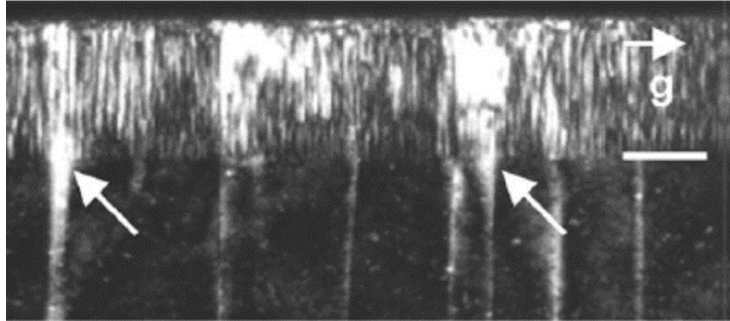
Figure 8. Cross-sectional TEM images of InAlN layer showing phase separation [58]. Figure reproduced with permission from Appl. Phys. Lett.